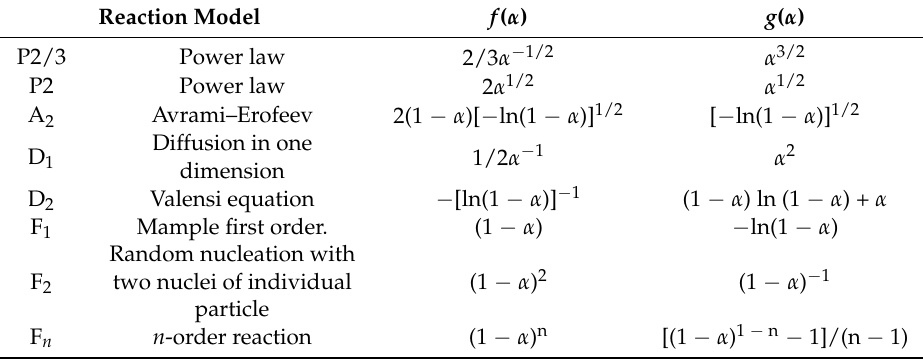
Table 1. Summary of some f ( α ) and g ( α ) functions corresponding to crosslinking of